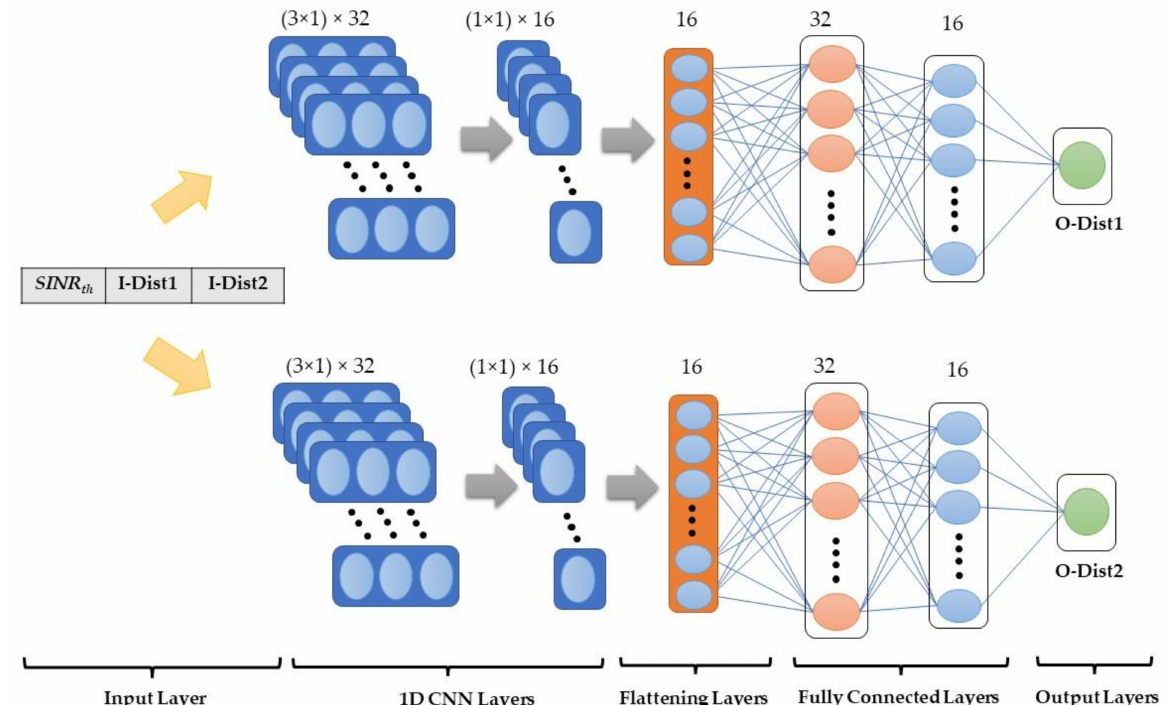
Figure 3. Proposed deep learning network that is to be used by each device independently to calculate optimal output